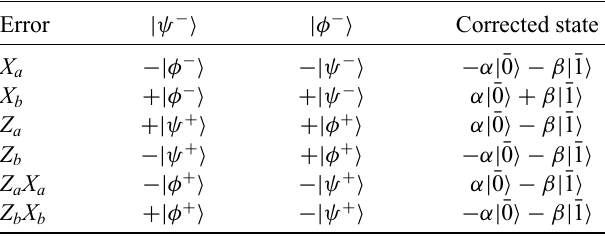
TABLE I. The effect of physical errors on logical basis states and the final corrected state after action of the qubot.